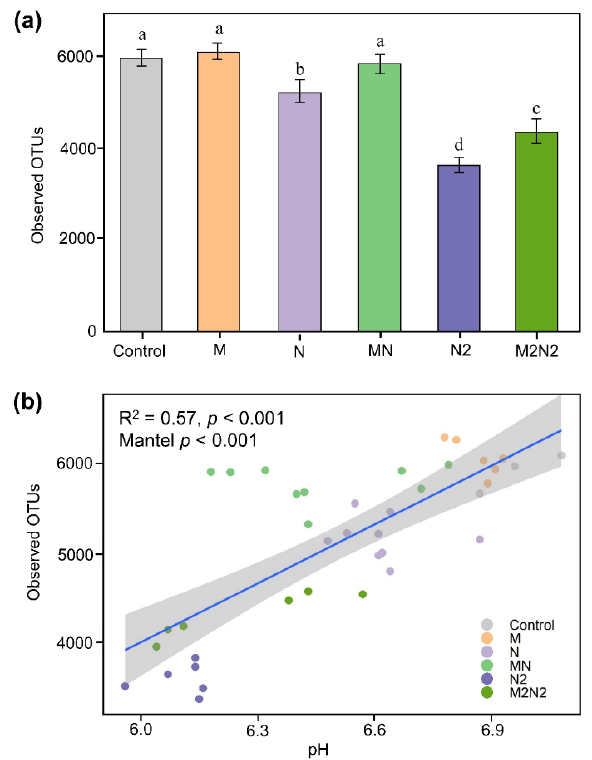
Figure 1. The impact of long-term fertilization to soil microbial diversity ( a ) and the relationship between observed OTUs richness and soil pH ( b ). Bars with different letters (shown in above) are significantly different ( p < 0.05).